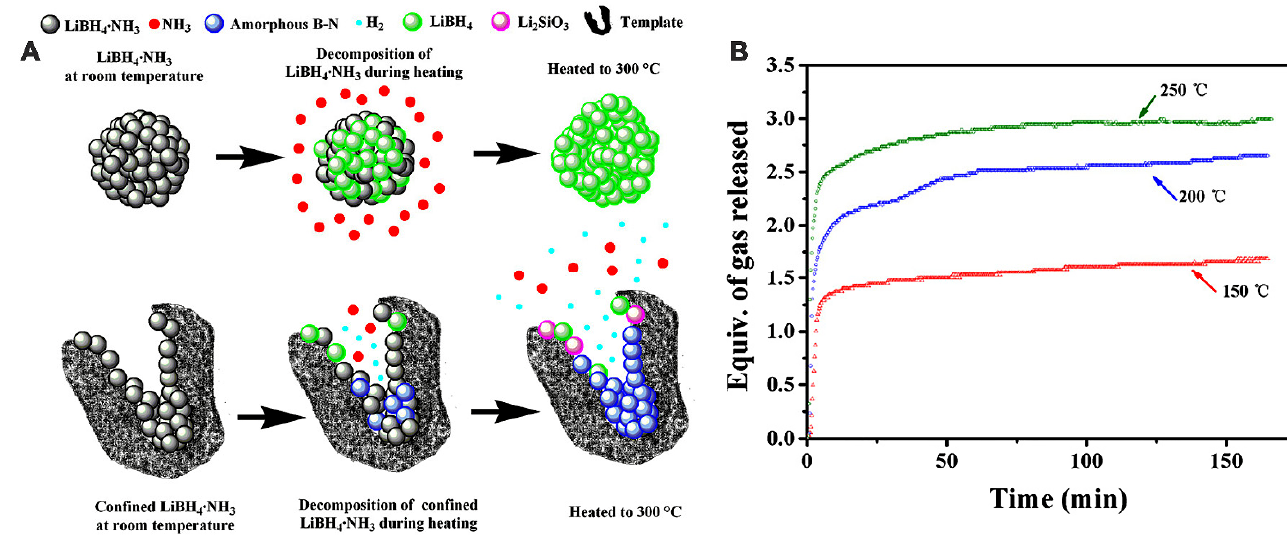
Figure 10. ( A ) Schematic model of LiBH 4 .NH 3 and confined LiBH 4 .NH 3 @SiO 2 , which displays the difference in their thermal decomposition. ( B ) The isothermal gas releases results on the confined LiBH 4 .NH 3 @SiO 2 (1:2, wt/wt) sample at 150 °C, 200 °C and 250 °C. Figure is reprinted with permission from ref. [189].